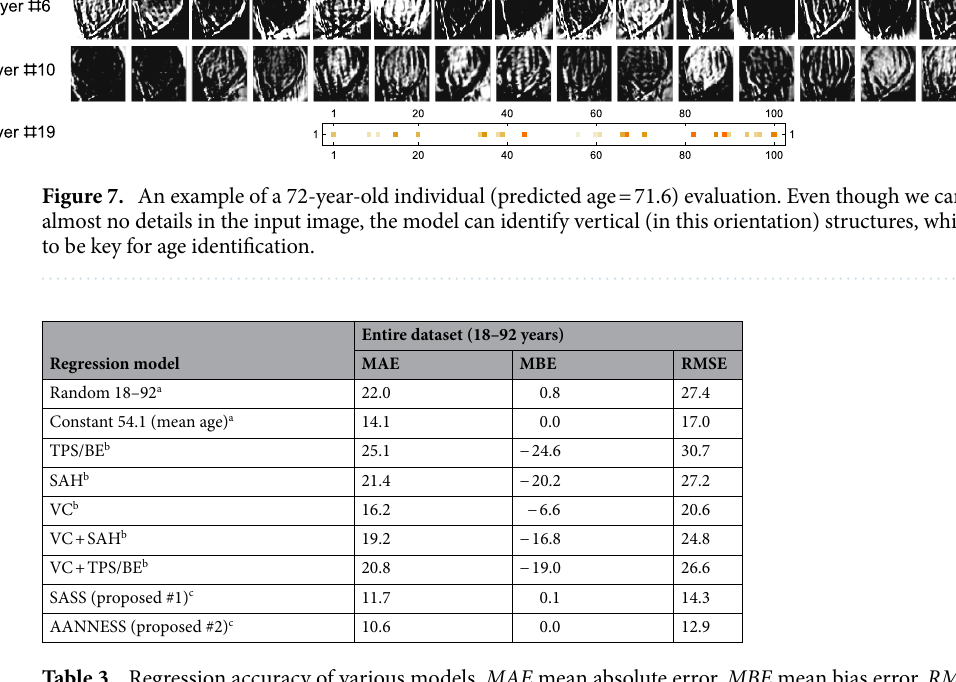
Table 3. Regression accuracy of various models. MAE mean absolute error, MBE mean bias error, RMSE root mean squared error, TPS/BE thin plate spline/bending energy, SAH slice and Algee-Hewitt score, VC ventral curvature, SASS Simple Automated Symphyseal Surface-based age estimation method, AANNESS Advanced Automated Neural Network-grounded Extended Symphyseal Surface-based age estimation method. When both right and left symphyses from a given individual are present, the estimated age is computed as the average from both bones. SASS and AANNESS are evaluated using fivefold cross-validation. a Baseline models. b Models by Stoyanova et al. 25 . c Proposed models by this